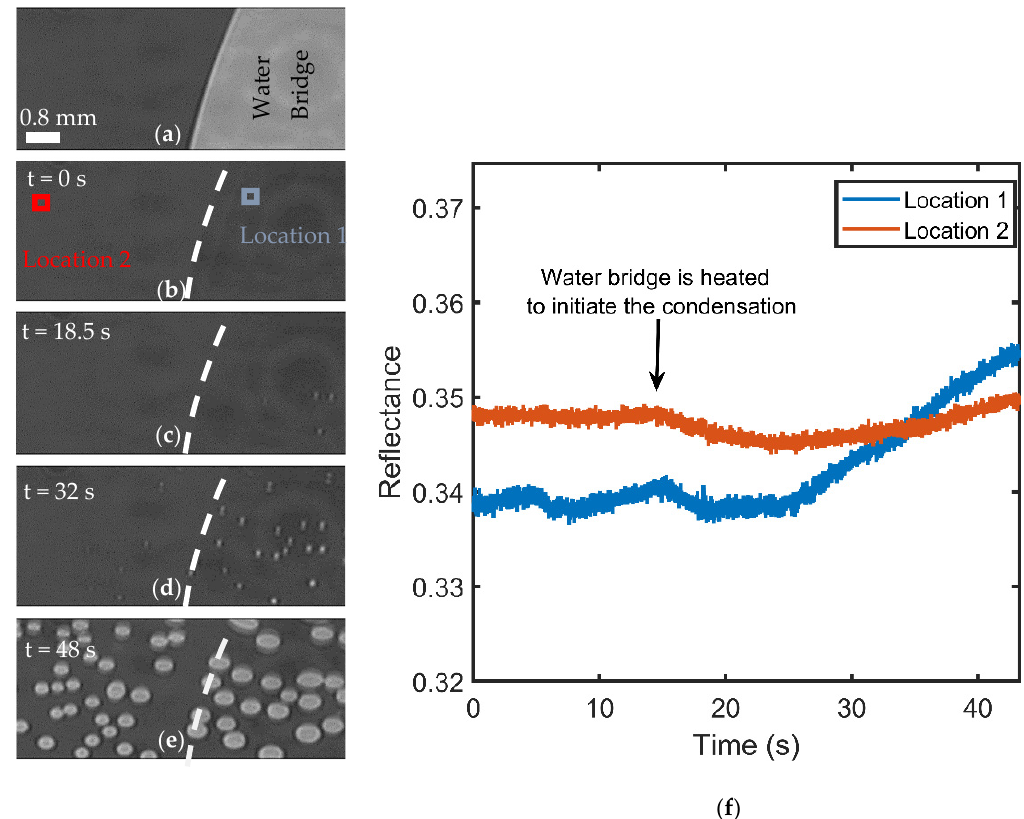
Figure 4. ( a ) Water bridge on the gold surface, ( b ) relocation of the water bridge, leaving behind an area that is darker in color; the gold surface in ambient condition (location 2) is covered with a monolayer of adsorbed water molecules, ( c – e ) time-lapse images of dropwise condensation on the surface, and ( f ) the reflectance of location 2 remained relatively constant up to 45 s, while the reflectance of location 1 increased.